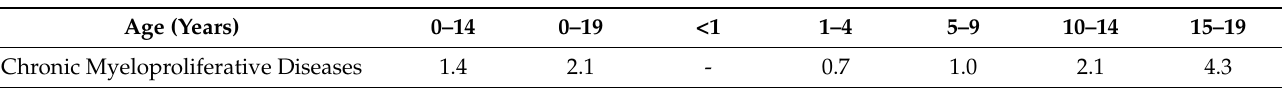
Table 4. Age adjusted and age specific incidence rates (per 1,000,000 children) of chronic myeloproliferatice diseases (all races, males and females) depicted from the SEERS database listing data from the USA in the years 2011–2015. [45]. Age